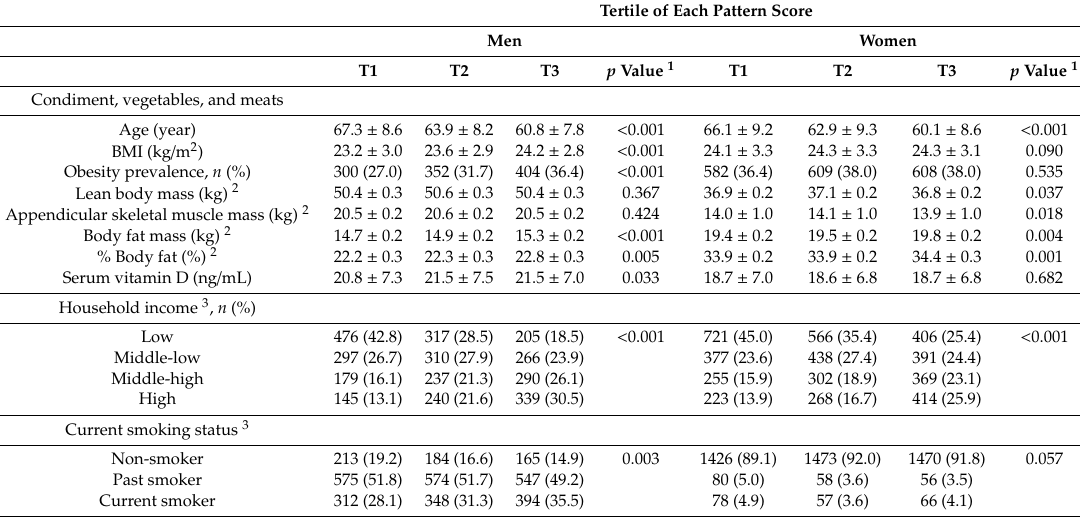
Table 1. General characteristics of study participants according to the tertiles of each dietary pattern score by sex.